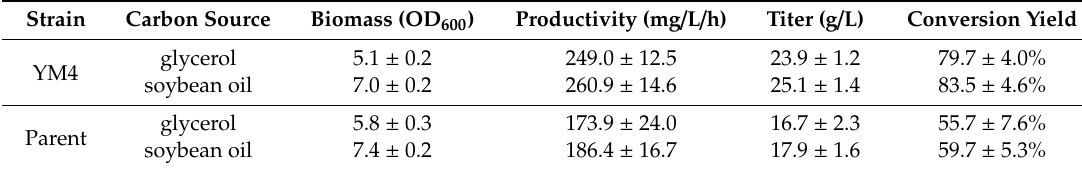
Table 1. E ff ects of the carbon source on rhamnolipid production.